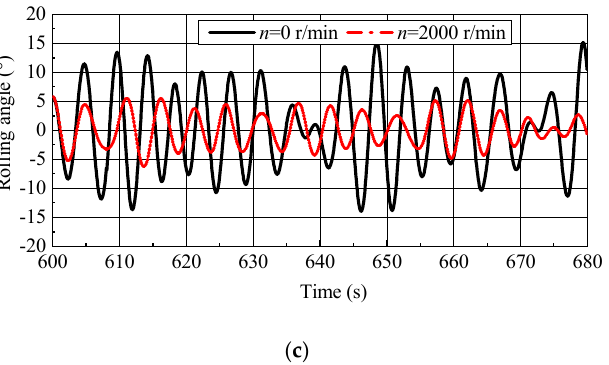
Figure 13. Time-series roll motion for varying wave periods. ( a ) T = 2.0 s; ( b ) T = 3.0 s; ( c ) T = 5.0 s.